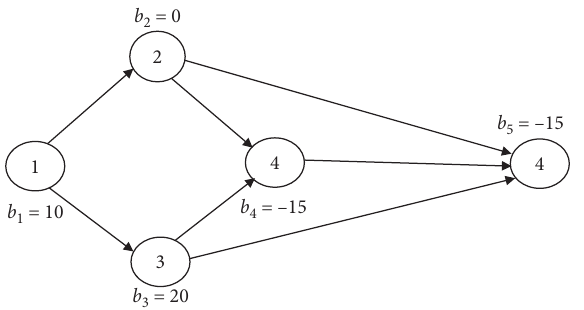
Figure 2: A network with 5 nodes and 7 arcs